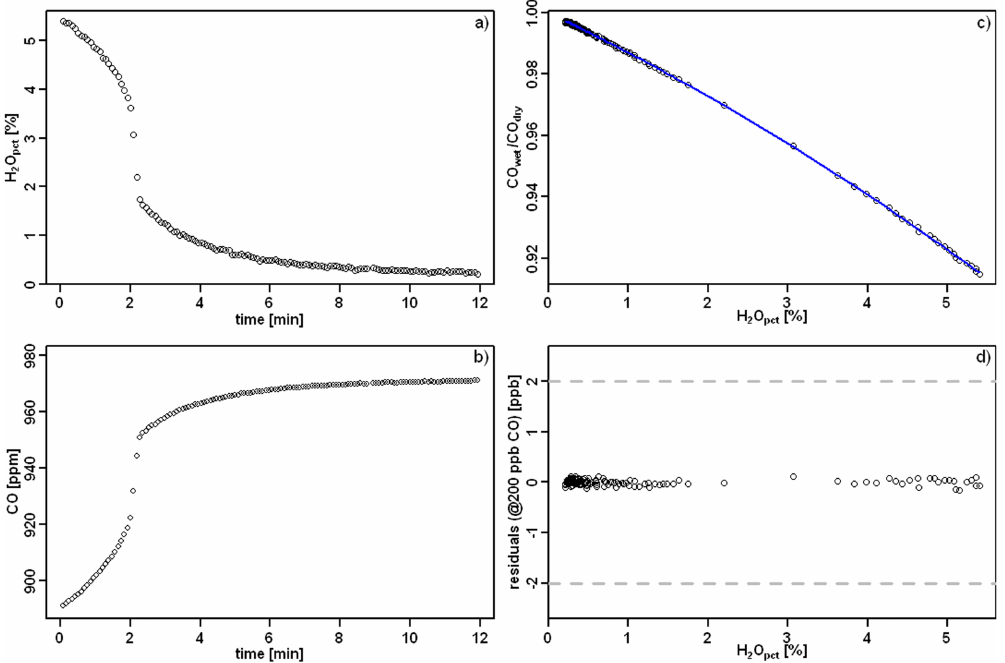
Fig. 2. Experimental data and analysis results during a water test using air with a high mole fraction of CO ∼ 1000ppm: (a) and (b) time series of H 2 O pct and mole fractions of measured CO during the test, respectively; x-axis is given in minutes relative to the start of the experiment. (c) Plots of CO wet /CO dry vs. H 2 O pct and a quadratic fit (curve in blue). (d) The black circles are residuals of the curve fit in (c) when applied to 200ppb dry mole fraction of CO, with a standard deviation of 0.06ppb; dashed lines indicate the compatibility goals set by the WMO for CO